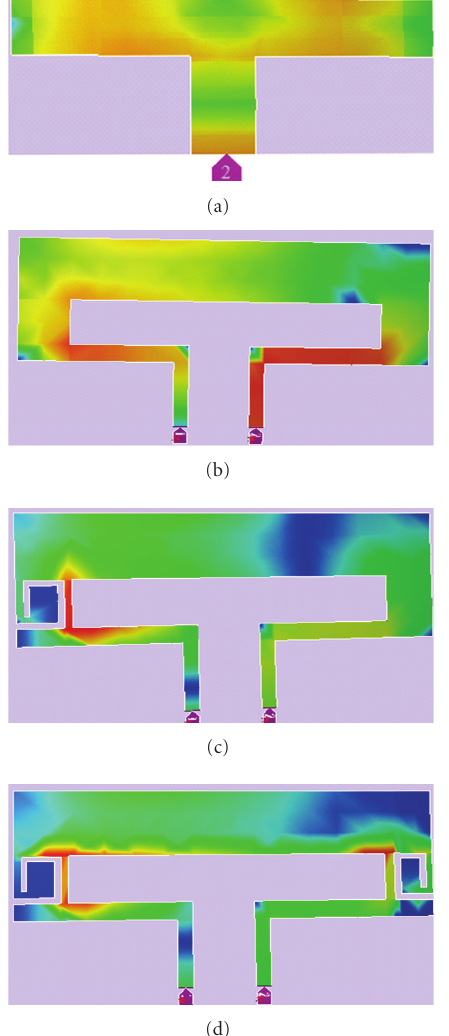
Figure 12: Current distribution. (a) Front view and back, (b) without slot, (c) with slot A, (d) with slot (A and A (cid:2)